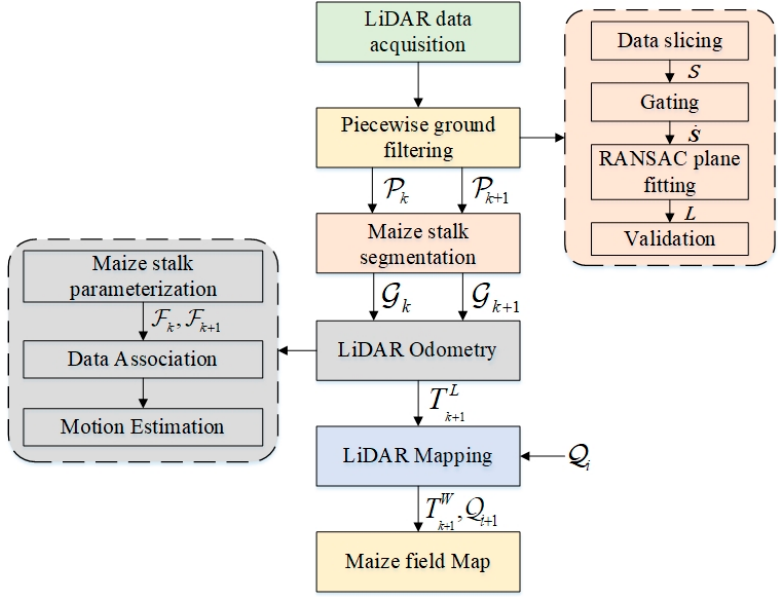
Figure 2. Flow chart of LiDAR data processing.